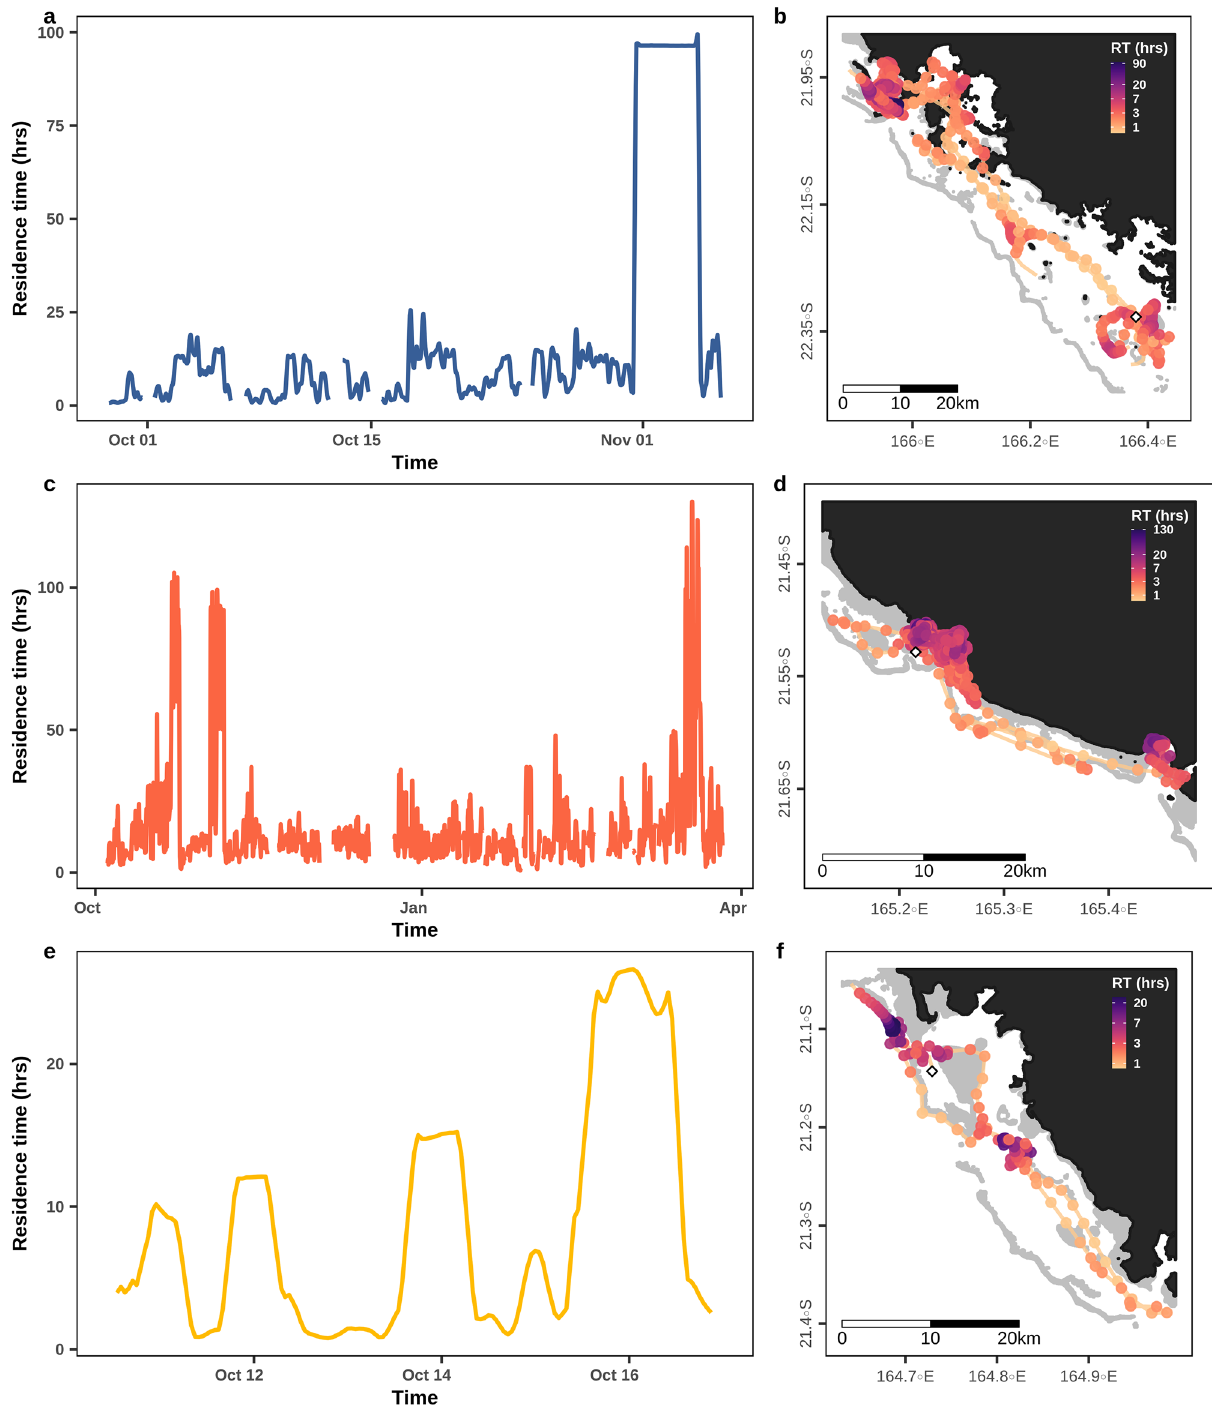
Figure 2. Residence time calculated over the interpolated GPS tracks of three different dugongs distributed in each of the New Caledonia west coast ecoregions. Panels ( A , B ): individual E in ecoregion 1. Panels ( C , D ): individual K in ecoregion 2. Panels ( E , F ): individual N in ecoregion 3. In the panels ( B , D , and F ) the color gradient representing residence time at each location is log scaled. The locations of tag deployments are shown with white diamond shapes. Land is represented in black and shallow reefs in grey (shapefile source: Millenium Coral Reef Mapping Project 69,70 ). The maps were created with R (version 3.6.3, www.r- proje ct. org 86